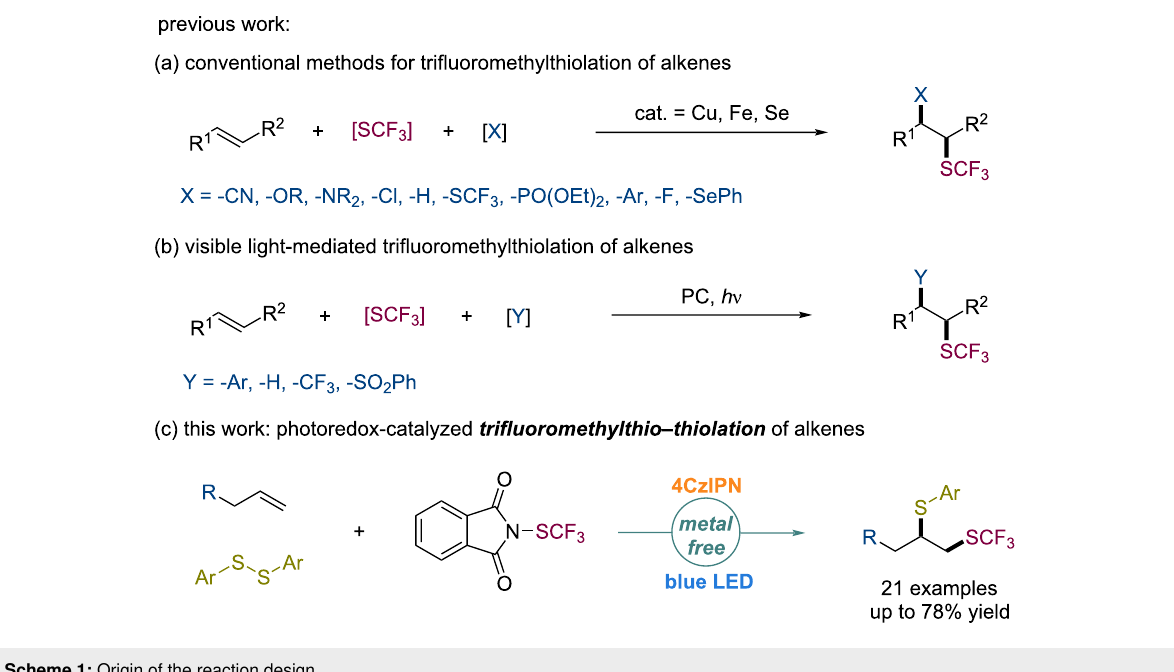
Scheme 1: Origin of the reaction